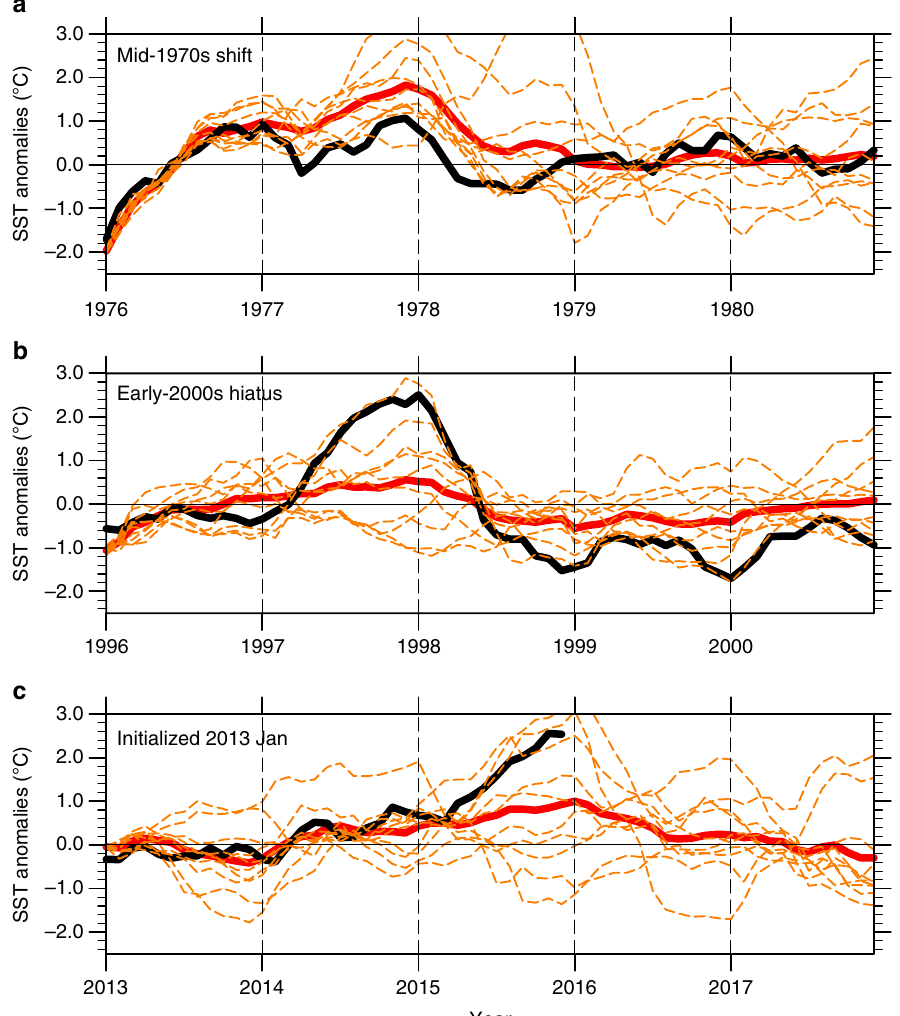
Figure 3 | Initialized predictions of eastern equatorial Pacific sea surface temperatures. Monthly mean time series of initialized predictions for the Nin˜o3.4 area (5 (cid:2) S–5 (cid:2) N, 120 (cid:2) W–170 (cid:2) W), calculated as anomalies from a 1975 to 2014 climatology; observations (black lines 34 ), individual model ensemble members are dashed orange lines; ensemble average is solid red line; ( a ) prediction for the mid-1970s shift, initialized 1 January 1976 (ref. 1); ( b ) prediction for early-2000s hiatus, initialized 1 January 1996 (ref. 4); ( c ) prediction initialized 1 January